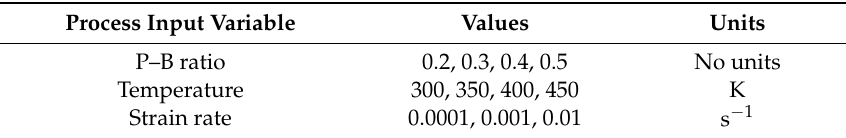
Table 2. Input parameters for tensile loading simulation of AZ31 alloy.